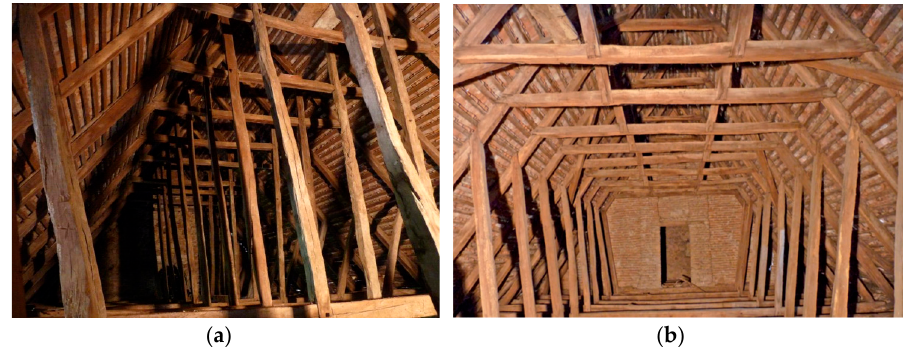
Figure 2. Romanesque roof structures: ( a ) roof structure Lutheran church in Vurpar; ( b ) roof structure Lutheran church in Toarcla.